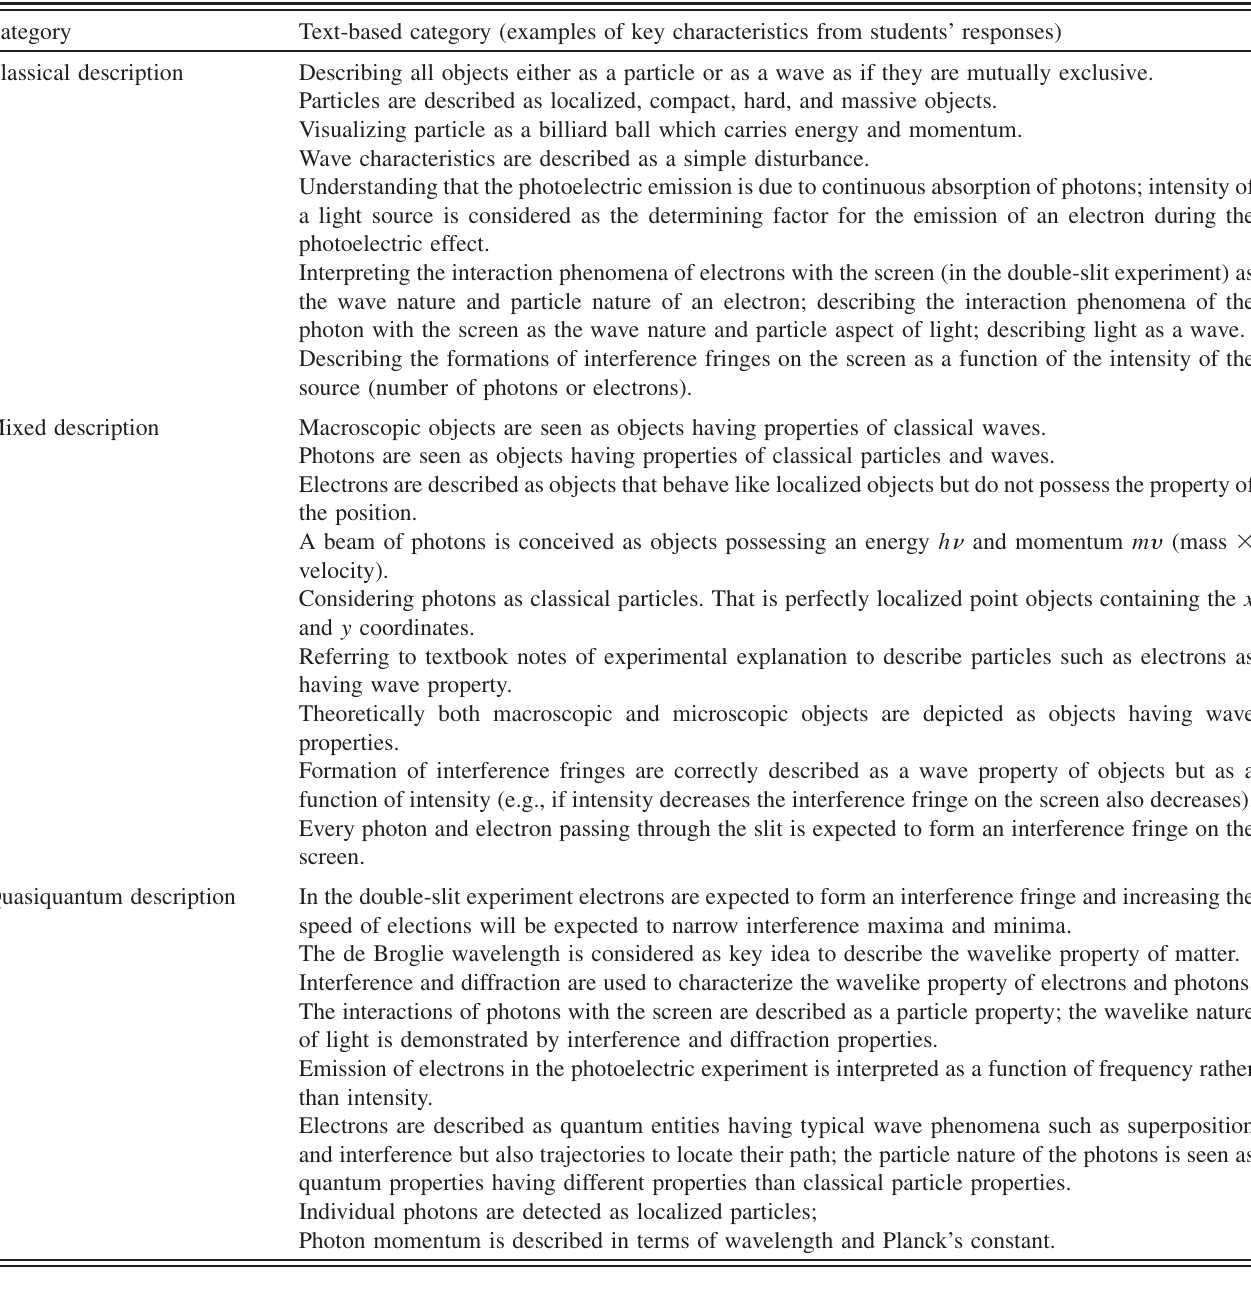
Table III outlines the four principal categories of de- scription identified and the text-based categories (key char- acteristics of each category) for students’ depictions of the uncertainty principle.